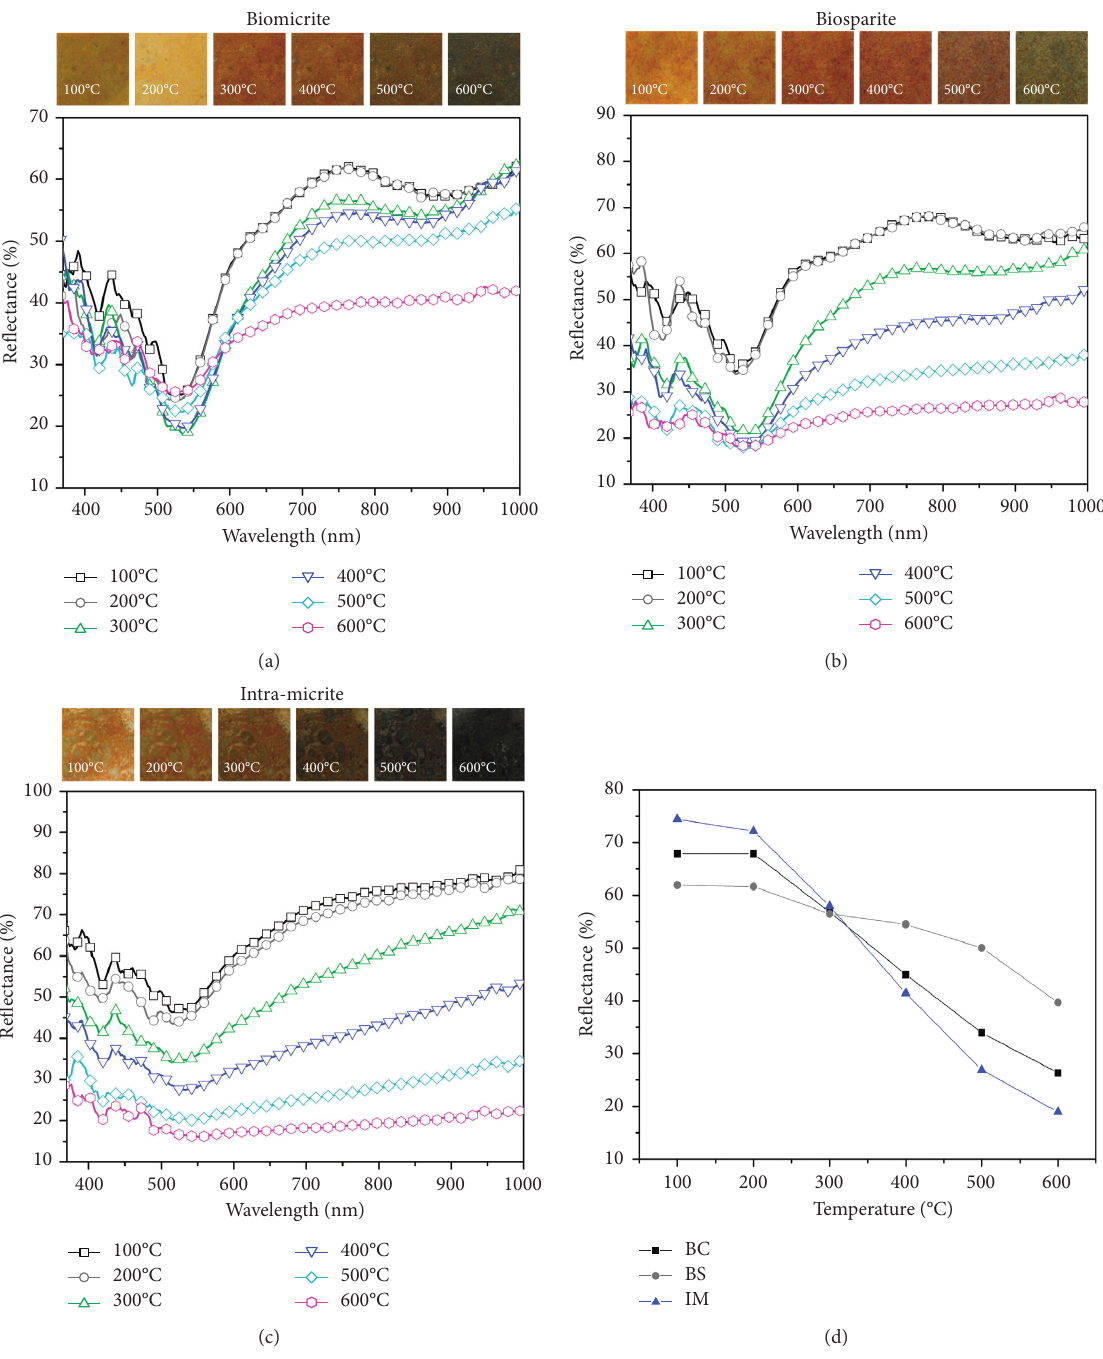
Figure 6: Diffuse reflectance spectra as a function of thermal treatment for limestone rocks: (a) BC, (b) BS, (c) IM, and (d) reflectance variation due to heating at a fixed wavelength of 765nm. The photographic images just give an illustrative guide of the optically observed changes induced by